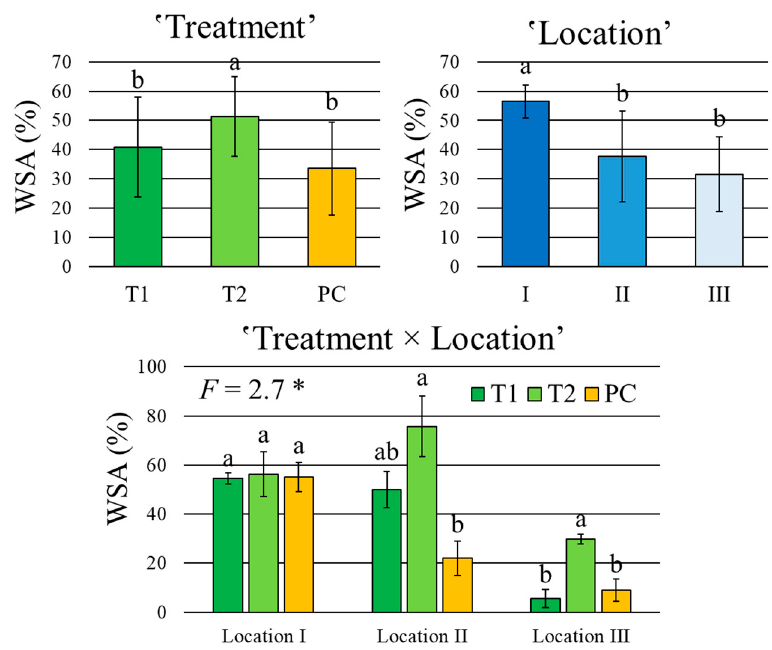
Figure 4. Weed-suppressive ability (WSA) of DiS-NH 2 bioherbicide mimic on durum wheat crop in relation to main effects (treatment and location) and their interactions. Bars represent the standard deviation ( n = 3). Different letters and * indicate the statistical significance at p ≤ 0.05 (Fisher’s LSD test). T1: DiS-NH 2 at a standard dosage (0.75 g m − 2 ); T2: DiS-NH 2 at a double dosage (1.5 g m − 2 ); NC: negative control (no weeding); PC: positive control (chemical